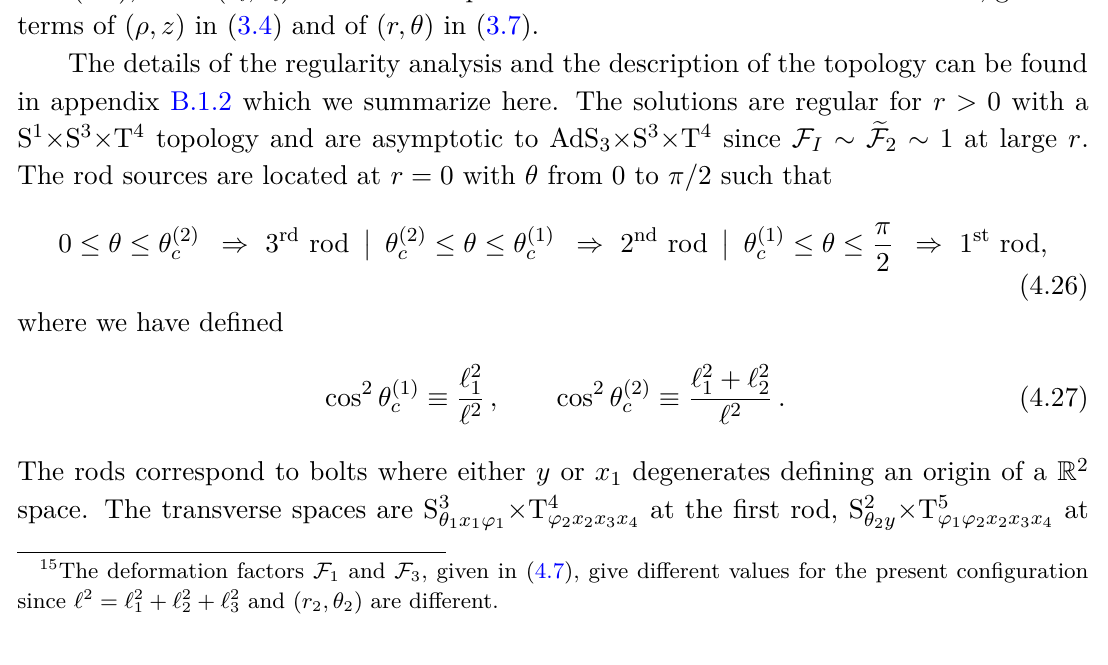
Figure 7 . Schematic description of the spacetime induced by a chain of three rods, two inducing the degeneracy of the S 1 ( y ) with one in the middle inducing the degeneracy of a T 4 direction ( x On the left-hand side, we depict the overall geometry in terms of r . On the right-hand side, we describe the behavior of the S 3 , S 1 , and T 4 at r = 0 and as a function of θ